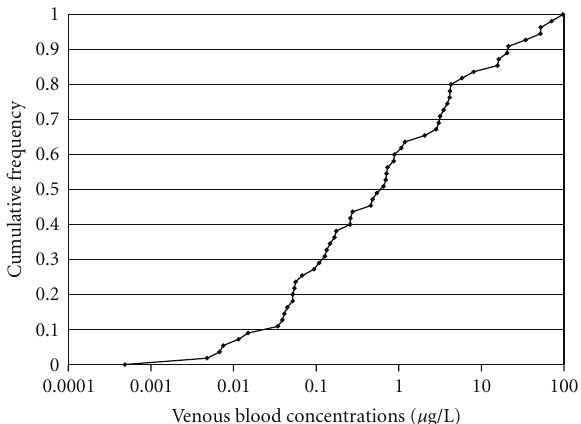
Figure 2: Estimated steady-state venous blood concentrations corresponding to oral and inhalation exposure guidance values (56 values) for 38 VOCs from Aylward et al. [42]. Some chemicals had both oral and inhalation exposure guidance values, while others had only